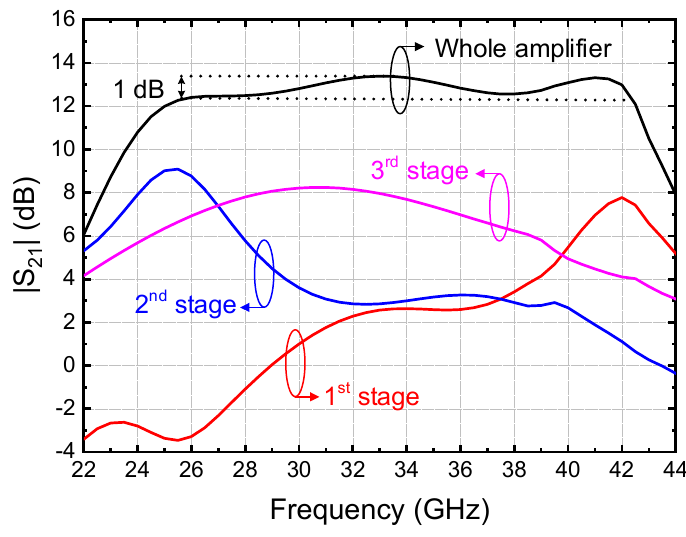
Figure 6. Gain of the three individual stages and the whole amplifier.